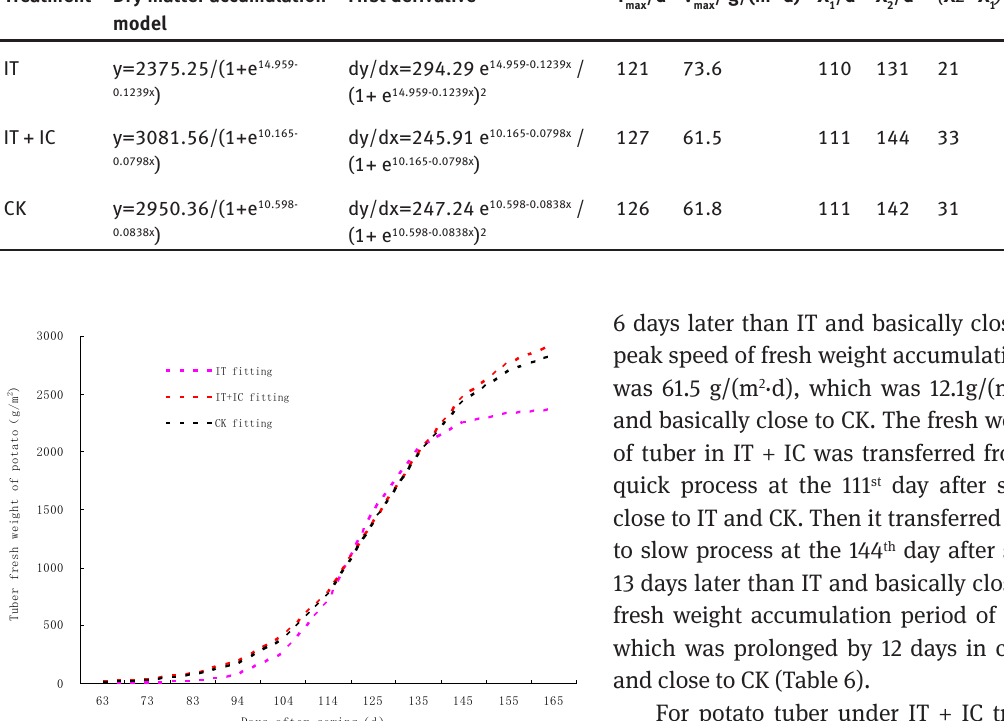
Table 6: Dynamic simulation and characteristic parameters of fresh potato tuber in different treatments. Treatment Dry matter accumulation